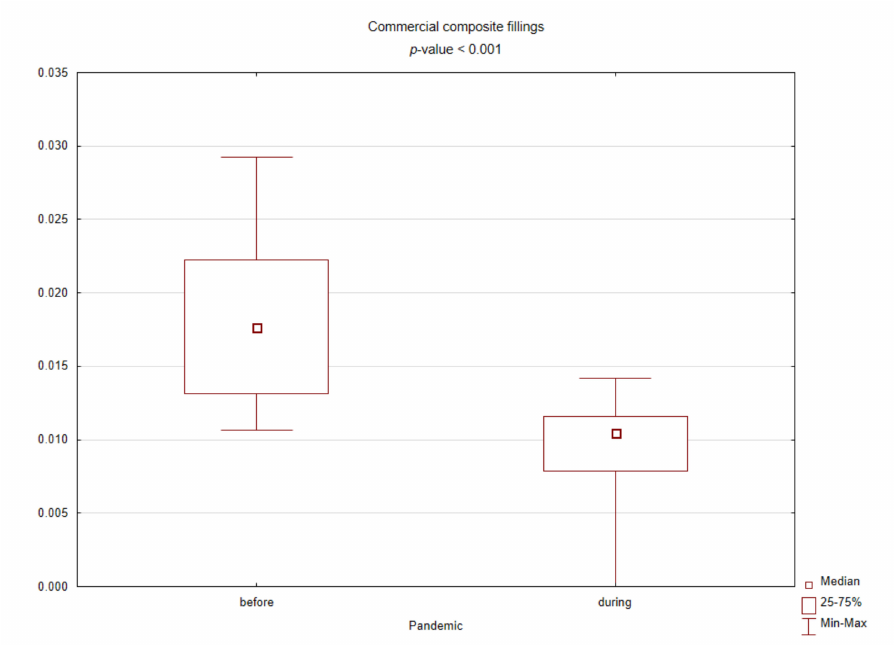
Figure 3. Box plot for the standardized number of commercial composite fillings before and during the COVID-19 pandemic ( p -value < 0.05 according to the Mann–Whitney